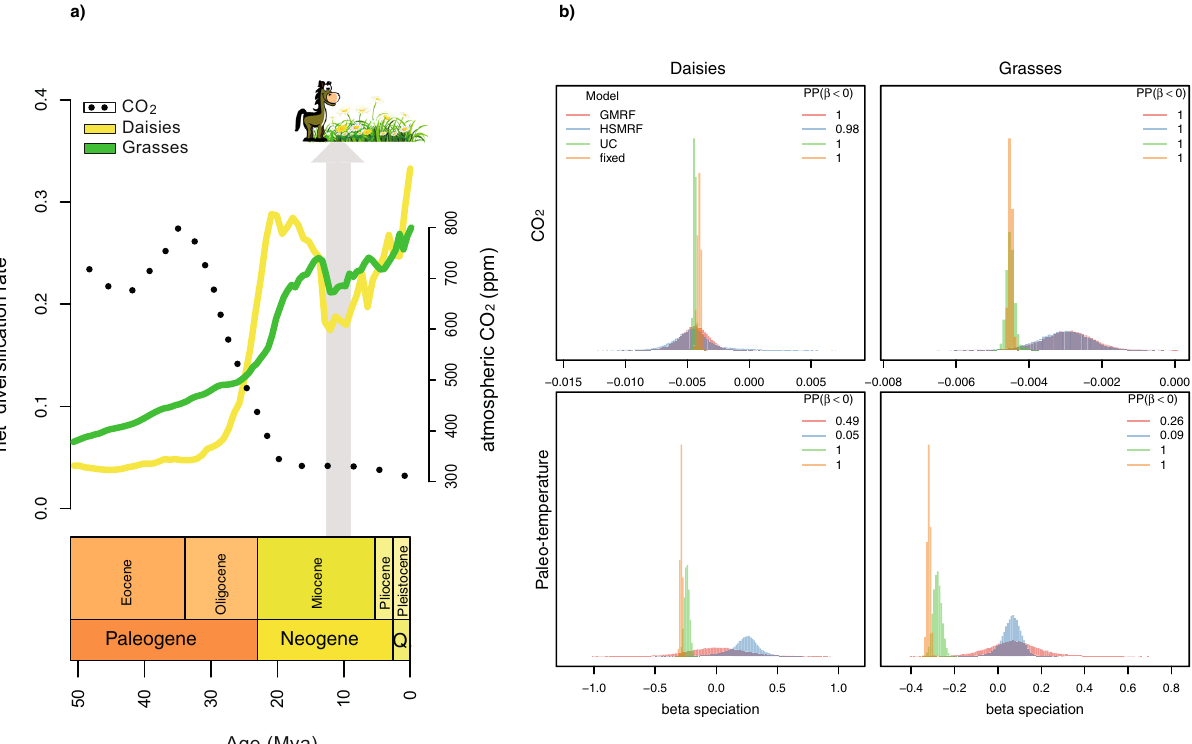
Fig. 3 Estimating diversi fi cation rates and correlation to CO 2 and paleo-temperature. a Diversi fi cation rates through time of daisies (yellow) and grasses (green) — calibration scenario #1 — for the last 50 Mya. Dotted line represents atmospheric CO 2 fl uctuations (22); note that the Oligocene steep decrease mirrors the onset of the increase in diversi fi cation of daisies and grasses. Gray arrow indicates a period (13 – 10 Mya) of lower diversi fi cation rates probably linked either with a brief increase in CO 2 (not represented in the dotted smoothed curve) or the explosive radiation of hypsodont grazers (e.g., horses) and other mixed feeder grazers 3 who may have had a tremendous impact on grasslands through their effects on plant populations and community composition. b The correlation factor ( β ) between diversi fi cation rates and CO 2 concentrations for daisies and grasses is signi fi cantly negative (posterior probability of 1.0 for all models except the HSRMF, which has a posterior probability of 0.98; Bayes factors of 37,501 and 49 respectively). The support for a negative correlation between paleo-temperature and diversi fi cation rates is ambiguous; the UC and fi xed models show signi fi cant support (posterior probability of 1.0, Bayes factor of 37,501) while the autocorrelated models show no support (posterior probability between 0.05 and 0.095, Bayes factors supporting a positive correlation of 1.04 and 17.86 for the daisy dataset and 2.85 and 9.75 for the grasses dataset for the GMRF and HSMRF models respectively). Note that the correlation factor β does not follow the same scale as common correlation coef fi cients (which are between − 1 and 1) but instead represents the factor by which to transform the environmental variable into diversi fi cation rates (see “ Methods ”